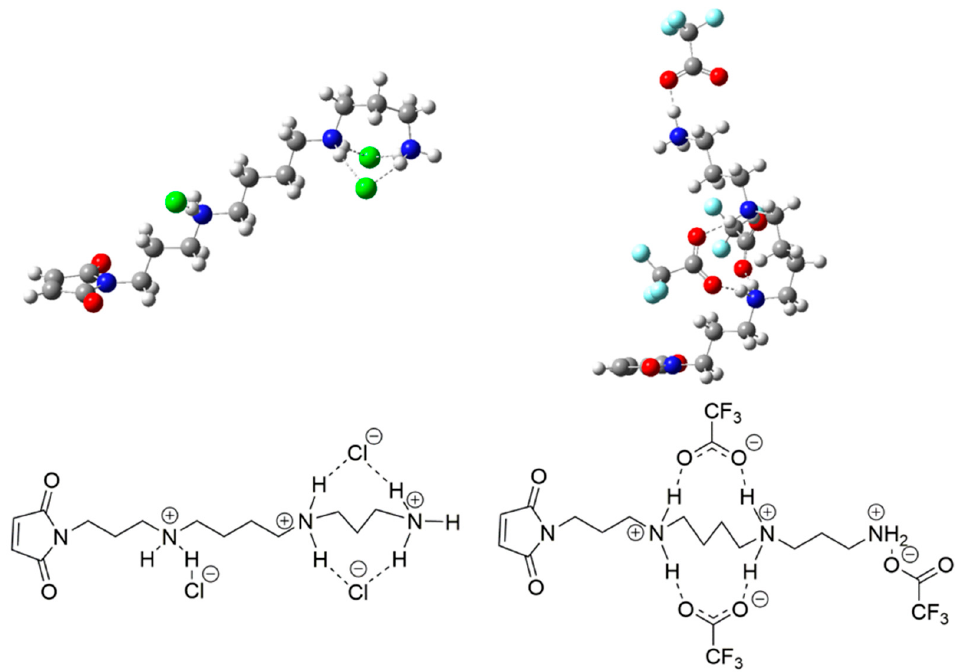
Figure 3. Energetically favored conformations for side chain models of the hydrochloride 4 ( left ) and trifluoroacetate salt 5 ( right ).